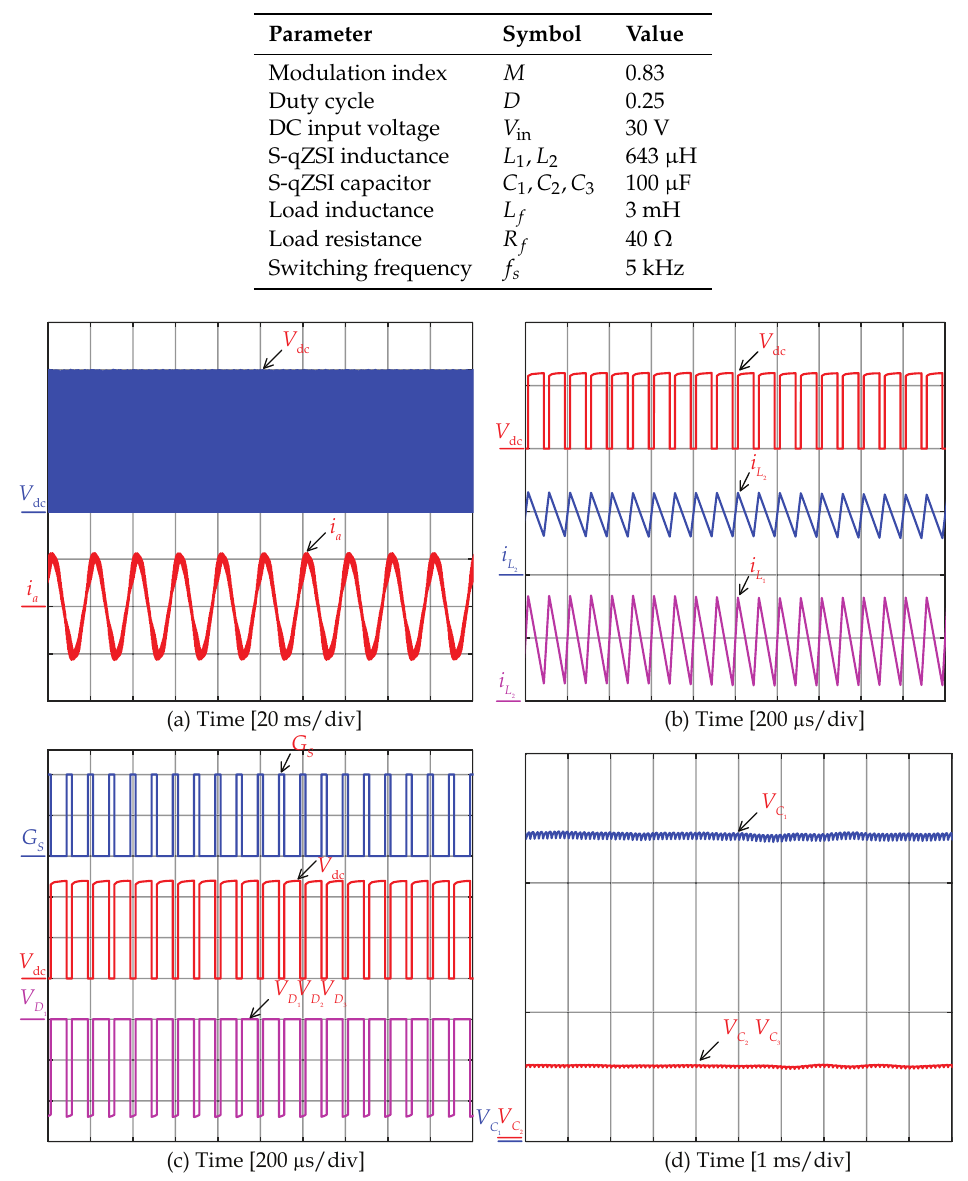
Table 4. Parameters of the proposed S-qZSI.